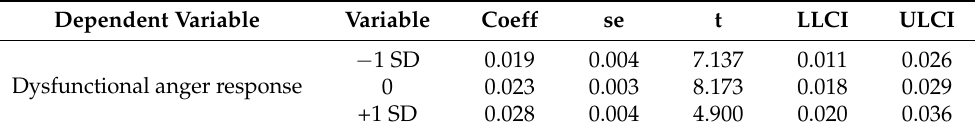
Table 5. Testing hypothesis result of effectiveness according to the magnitude of moderating variable.